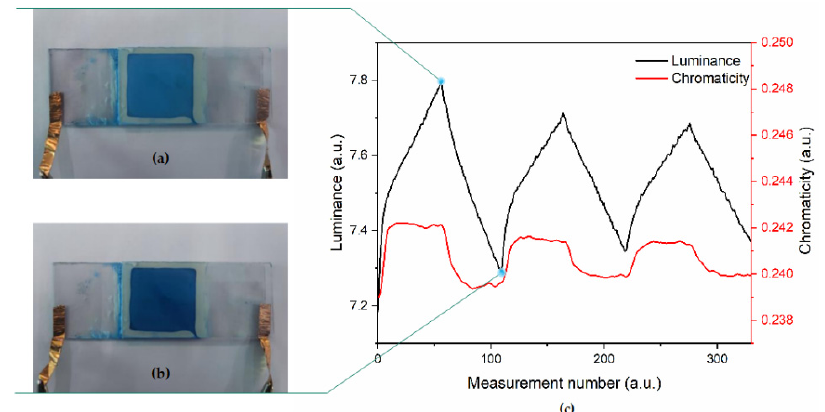
Figure 8. Photograph (top view) of the blue and white dual-color EPD cell with +50 V on the lower plate ( a ). Photograph (top view) of the blue and white dual-color EPD cell with +50 V on the upper plate ( b ). Curve change relationship between luminance and chromaticity coordinate of the EPD in driving process ( c ).